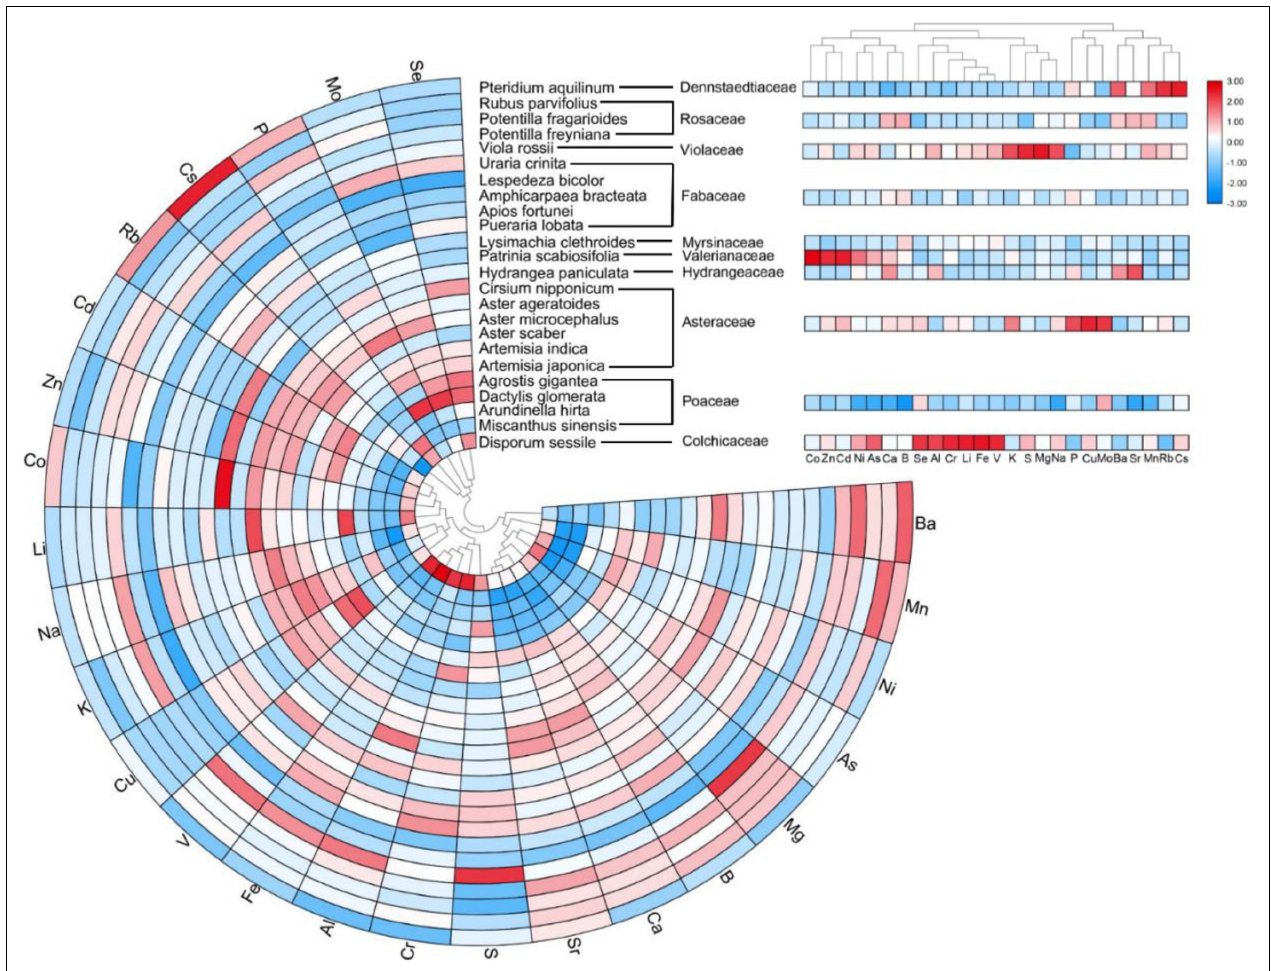
FIGURE 6 | Composite loop heatmap showing ionomes of leaf elemental concentrations in diverse plant species with their respective families. Hierarchical cluster analysis was applied to minerals but not to plant species. For better visualization, a log 10 transformation was conducted on raw data. Column data in plant species and families of different elements were